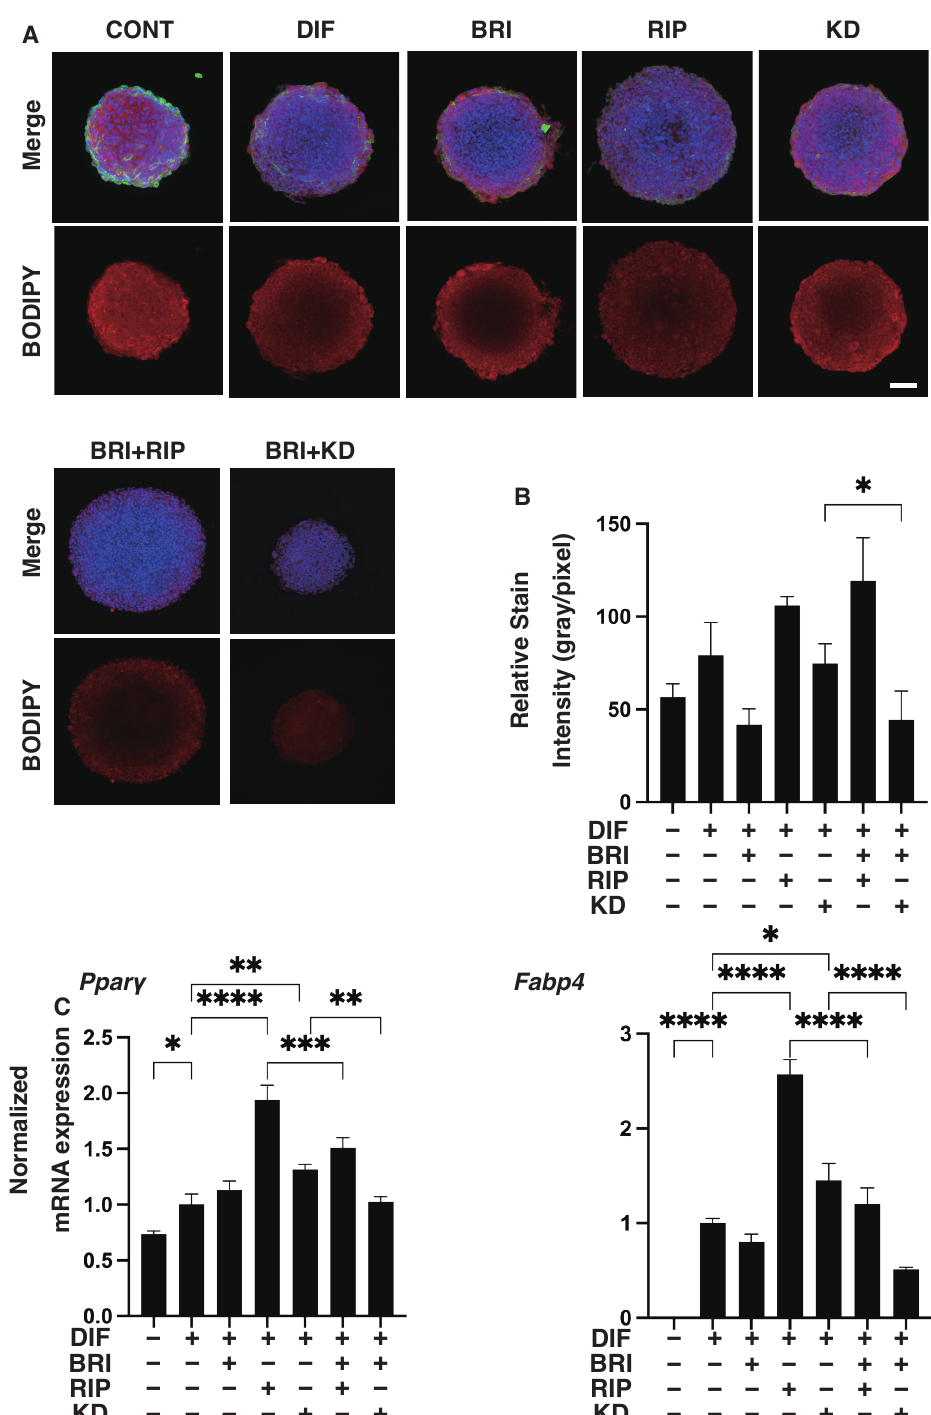
Figure 4. Effects of ROCK-i and/or BRI on adipogenic differentiation (DIF+) in 3D 3T3-L1 spheroids. The 3T3-L1 cells were 3D-cultured under several conditions: preadipocytes of 3T3-L1 cells (DIF − ) and their adipogenic differentiation (DIF+) with or without 10 µ M ripasudil (Rip) or KD025, and/or BRI. These were stained with BODIPY ( A , scale bar: 100 µ m), and their staining intensities were plotted ( B ). The mRNA expressions of DIF+-related genes, including Ppar γ and Fabp4, under the above conditions were plotted in ( C ) 1–3. All experiments were performed in triplicate using fresh preparations, each consisting of five samples. Data are presented as the arithmetic mean ± standard error of the mean (SEM). * p <0.05, ** p <0.01, *** p <0.005, **** p <0.001, and other pairs were not statistically significant (ANOVA followed by a Tukey’s multiple comparison